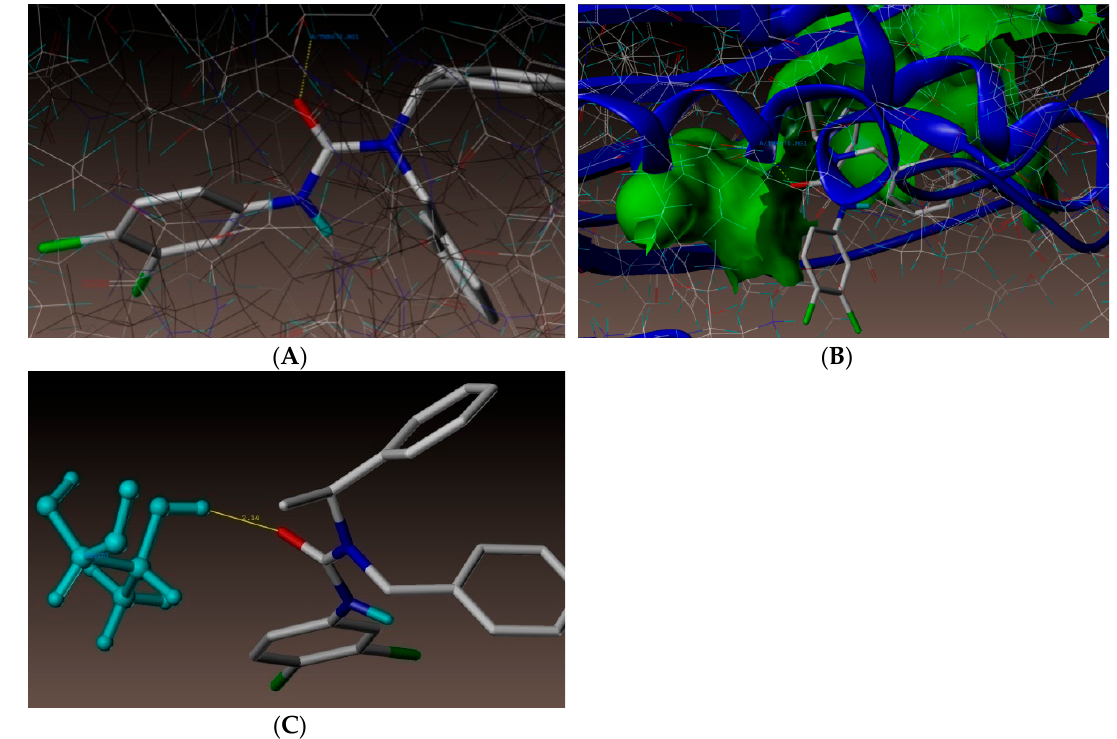
Figure 4. ( A ) Docked view of compound 3j . ( B ) Docked view of compound 3j at the active site of enzyme PDB ID: 3UDI. ( C ) Hydrogen-bond interaction of compound 3j at the active site.